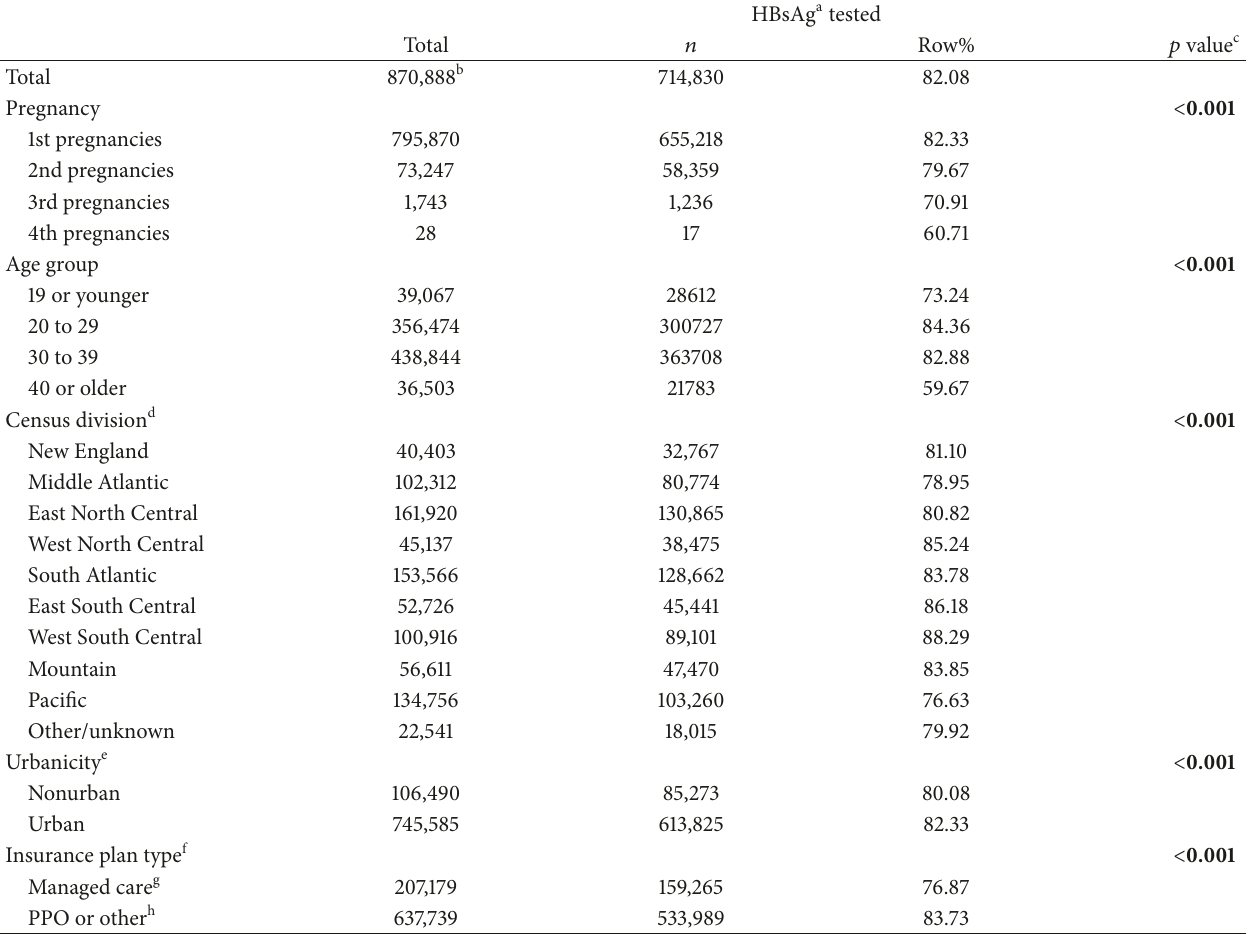
Table 2: Hepatitis B screening among 870,888 pregnancies in commercial insurance claims data,